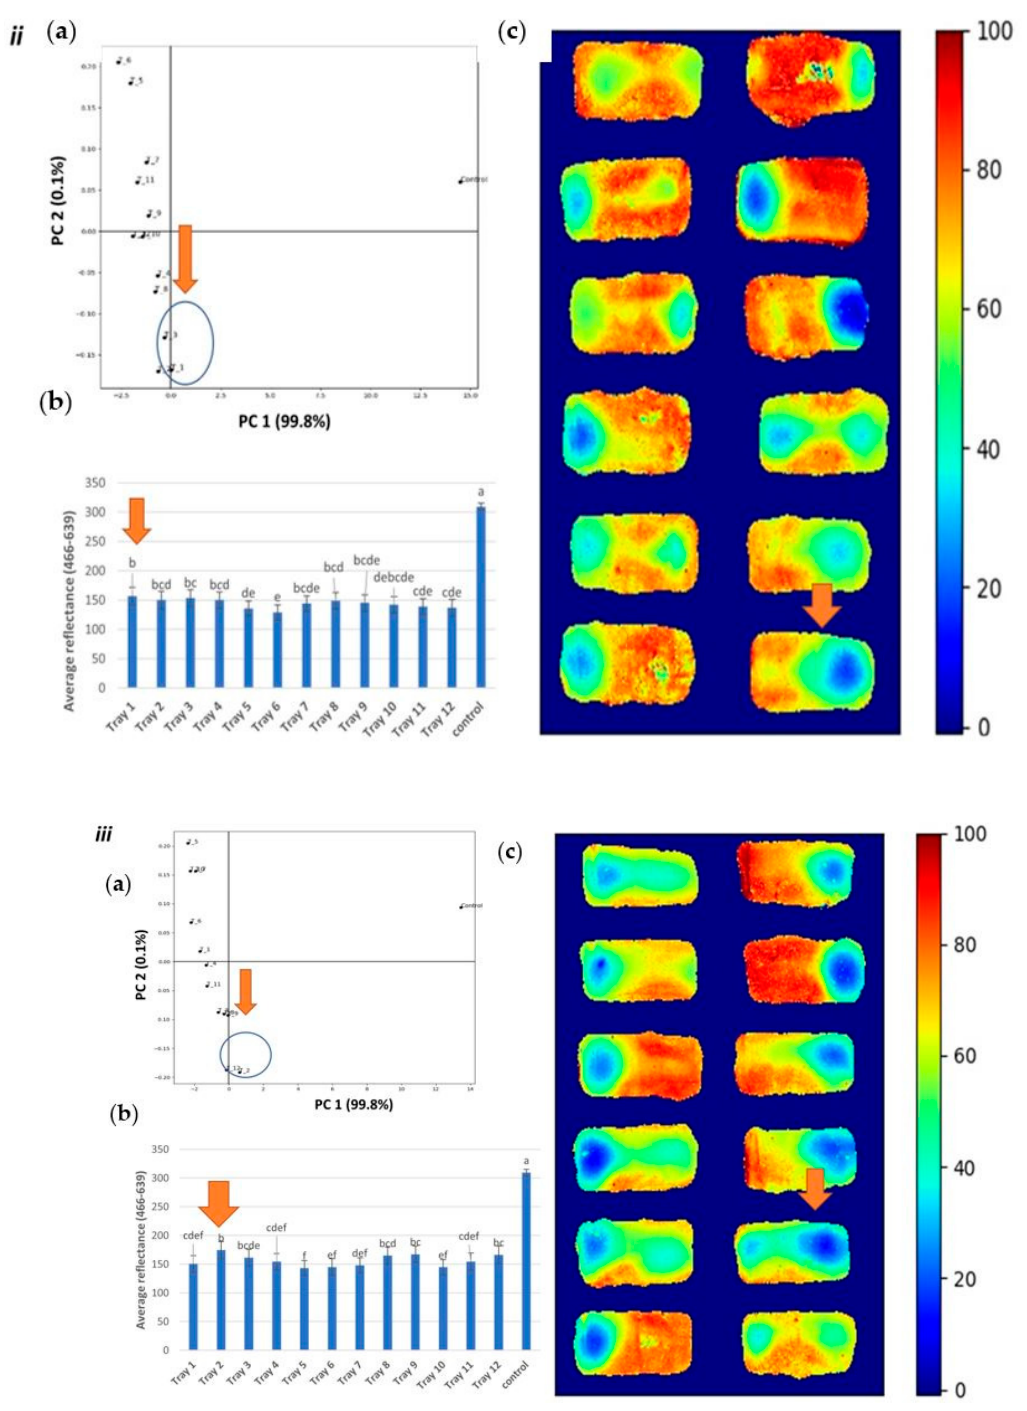
Figure 9. Hyperspectral analysis of processing runs (i, ii, and iii): PCA plot ( a ) average reflectance ( b ) and heat map ( c ) as a comparison of 12 trays (tray number 1 to 12 indicates its location in the processing vessel), where the image c in each figure indicates ‘zero’ (lowest amount of heat treatment) and ‘100’ (highest amount of heat treatment).